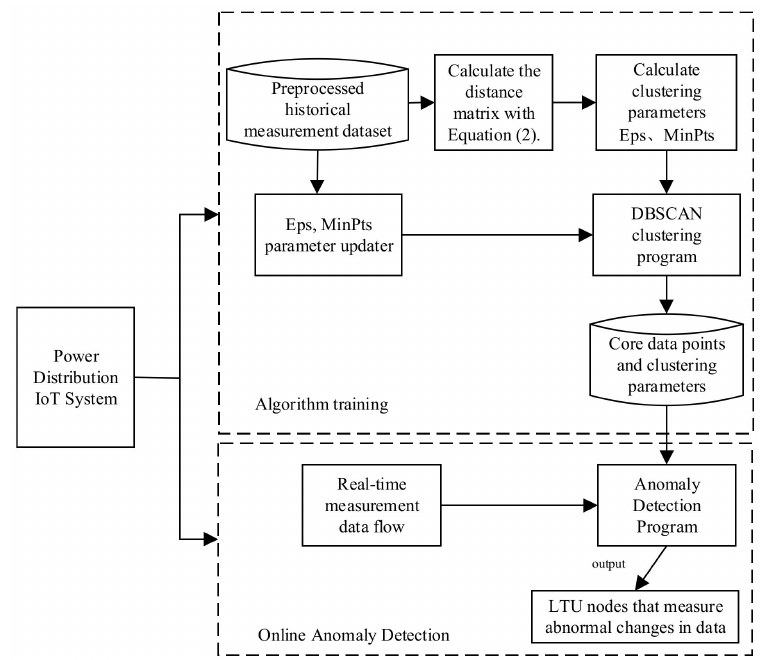
Figure 3. Anomaly data detection program architecture based on DBSCAN